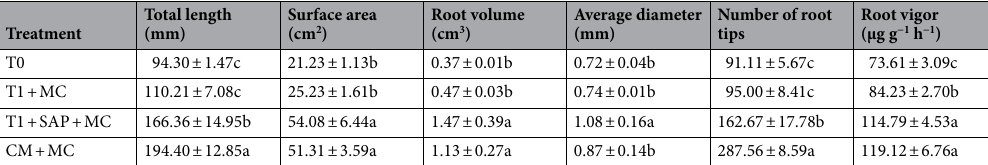
Table 10. Effects of different growing media combined with MC application on the root architectures of cotton seedlings. CM commercial media, SAP super absorbent polymer, MC mepiquat chloride foliar painting at the one-true-leaf